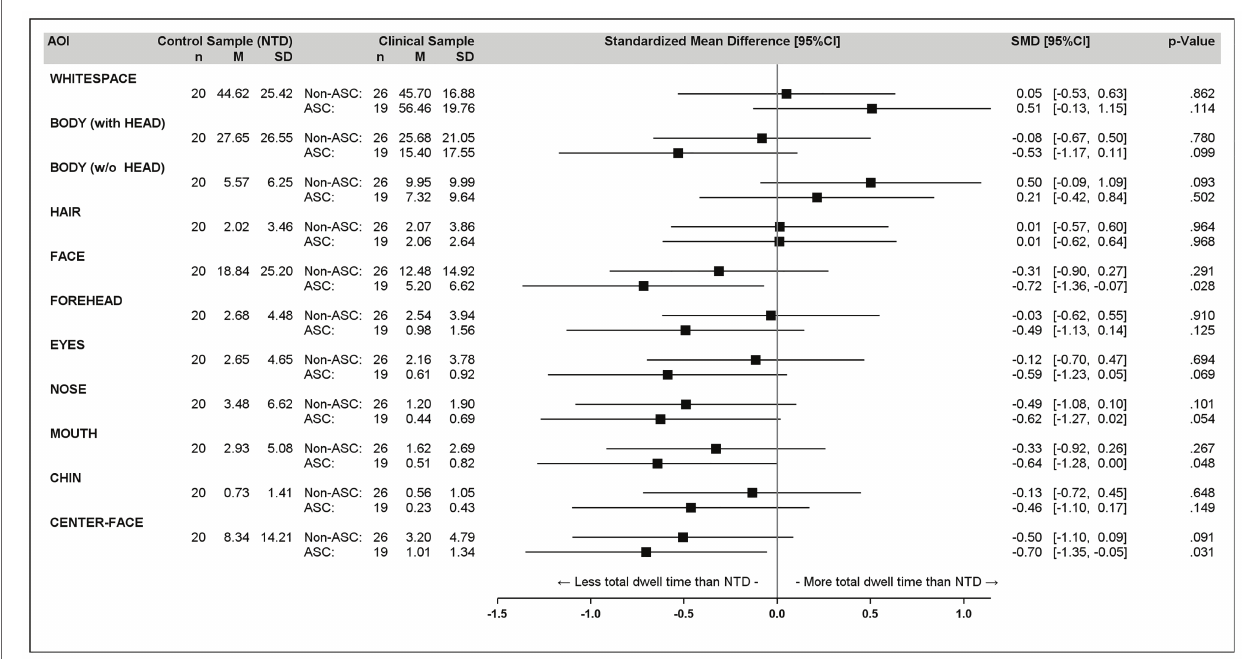
FIGURE 3 | Forest plot of total dwell time percentages for different areas of interest